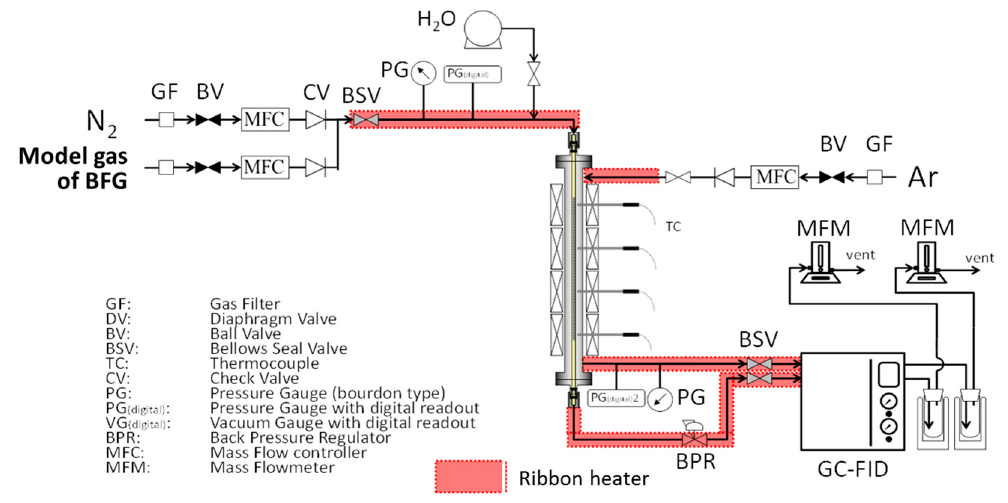
Figure 5. A schematic diagram of membrane reactor for the water gas shift reaction.